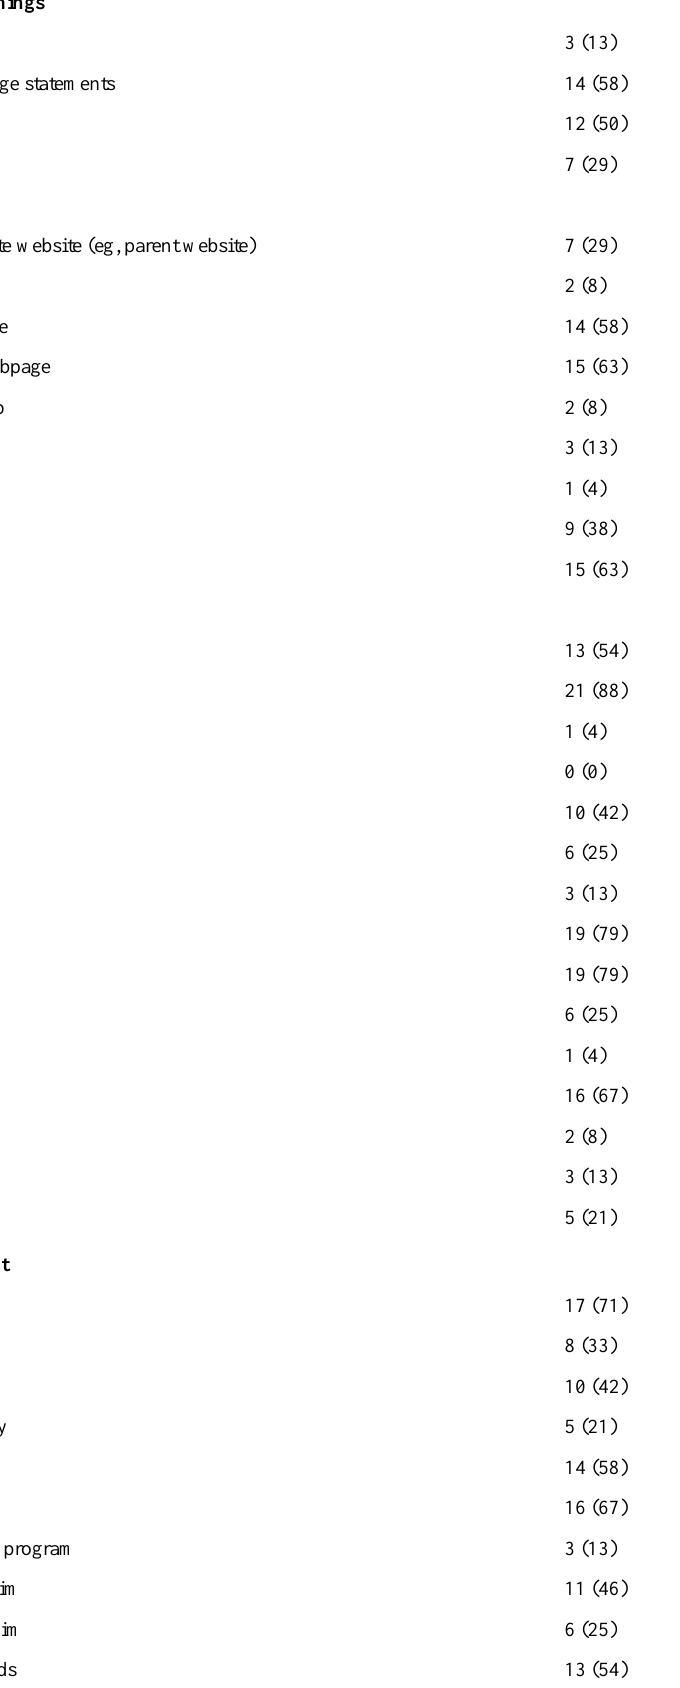
Code prevalence on corporate websites, n